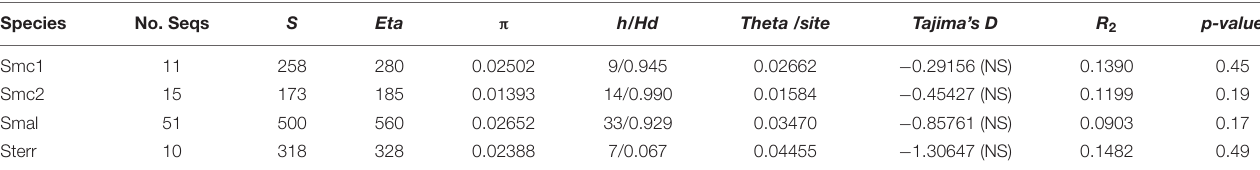
TABLE 4 | Descriptive statistics of DNA polymorphisms, neutrality and population growth tests for environmental isolates of the Smc1, Smc2, S. maltophilia (Smal) and S. terrae (Sterr) lineages recovered from Mexican rivers based on the concatenated dataset (3591 sites). Species No.